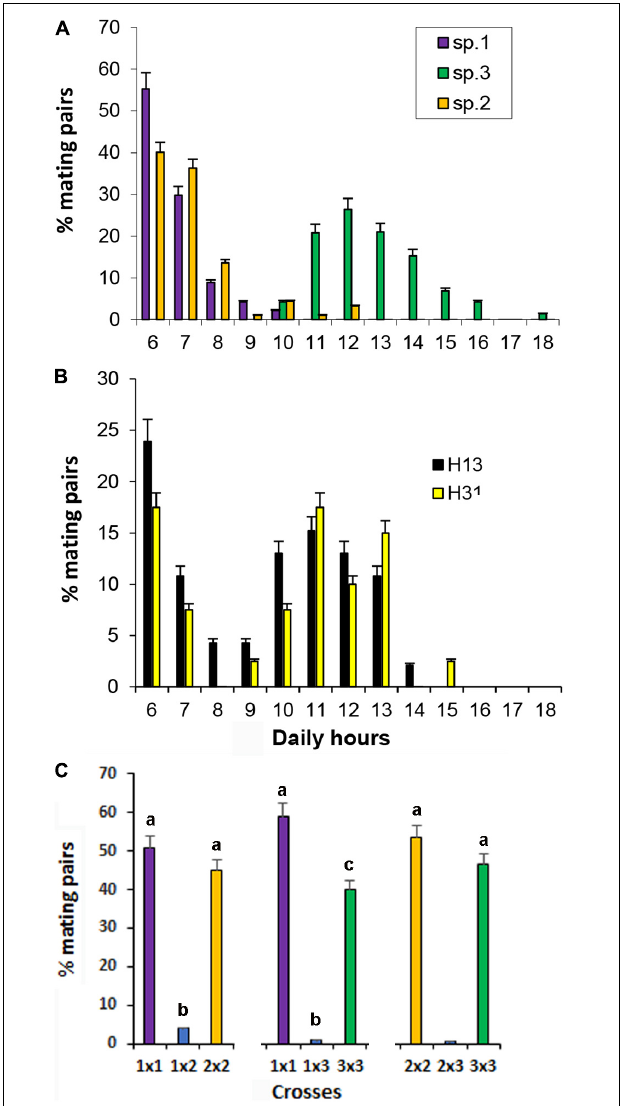
FIGURE 4 | Mating activities. (A) Mating activities of the three specie and (B) daily mating activities of laboratory F1 hybrids from A . sp.1 and A . sp.3 crosses; (C) percent of homospecific and heterospecific mating